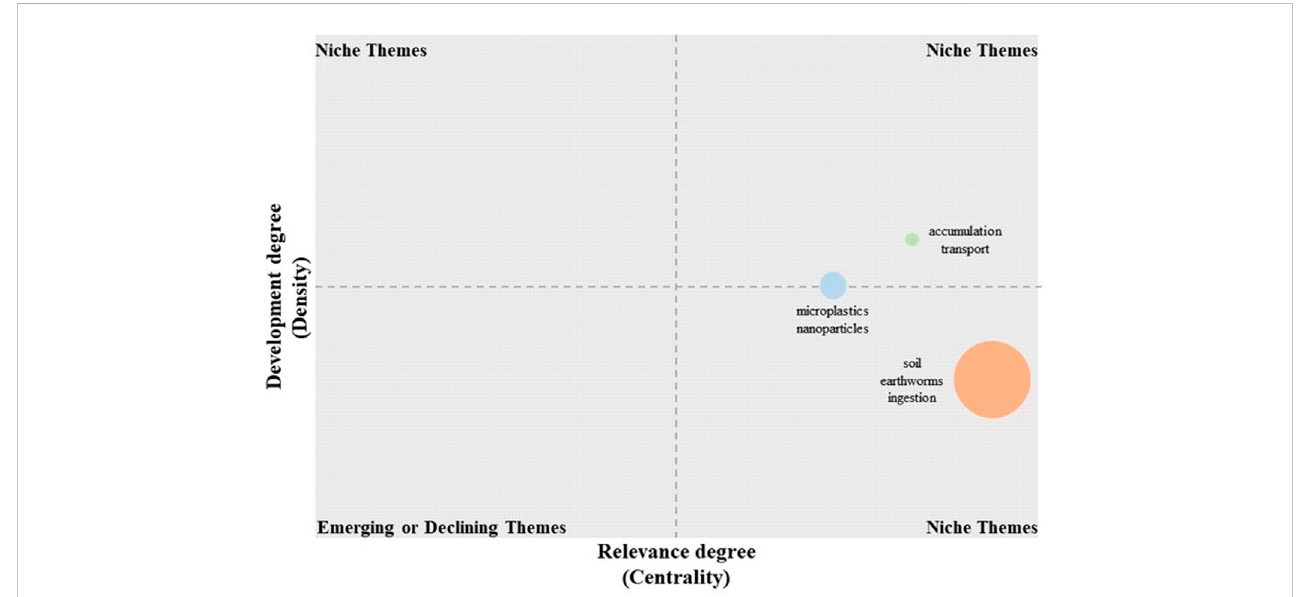
FIGURE 5 Keyword clustering of articles published from 2016 to 2017 focusing on microplastics and earthworms. The minimum frequency of occurrence (per 1,000 documents) for each research direction is more than fi ve. The size of the circles represents the number of articles published in the corresponding direction. The horizontal axis represents relevance (centrality), which measures the importance of a research direction in the overall development of the research fi eld. The vertical axis represents development (density), which measures the current state of development of a research direction.